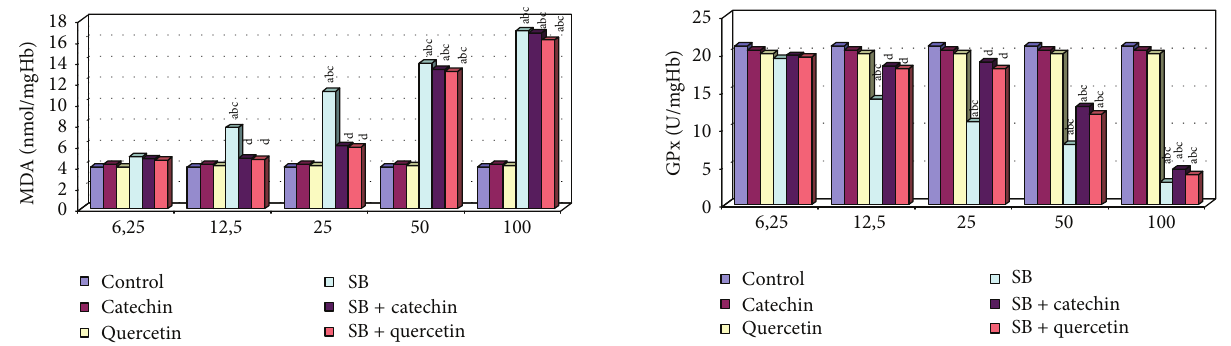
Figure 1: MDA level in erythrocytes of control and experimental groups. Different letters above bars indicate significant differences between exposure concentrations; bars with the same letter are not significantly different. Values are mean ± SD in each group. Significance at 𝑃 < 0.05 .